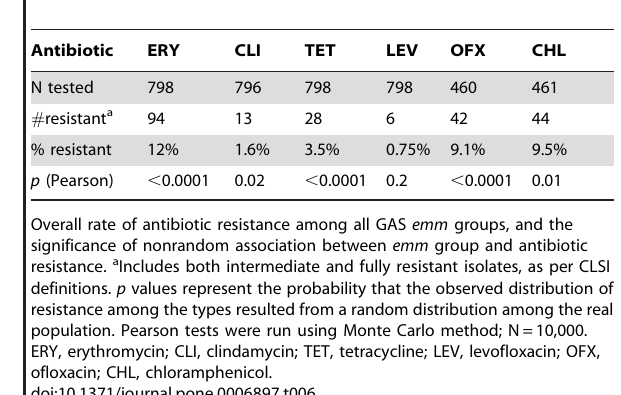
Table 5. Rates and significance of nonrandom distribution by sequenced emm type.